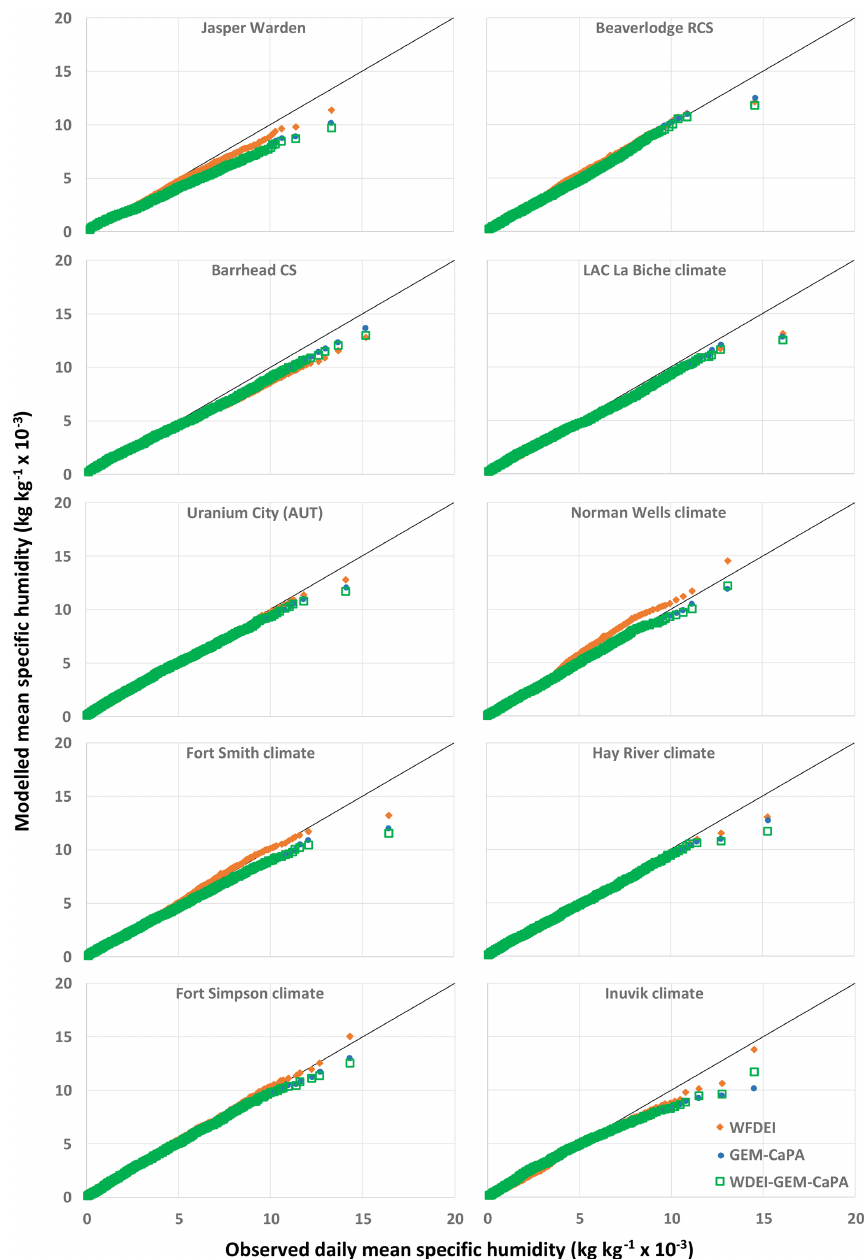
Figure 10. Quantile–quantile plots of modelled (GEM-CaPA, WFDEI, and WFDEI-GEM-CaPA) and observed daily specific